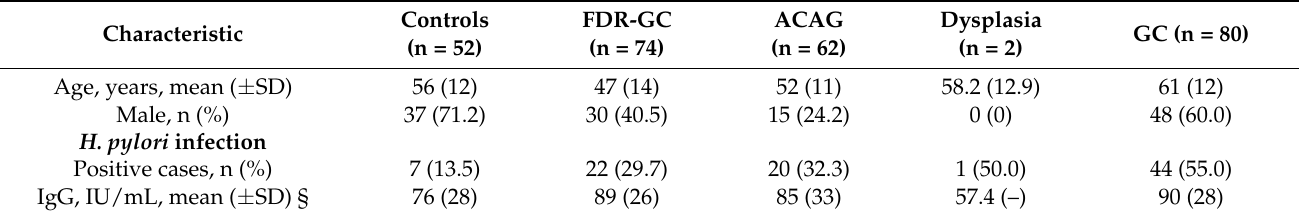
Table 2. Baseline characteristics of study subjects, by study group.